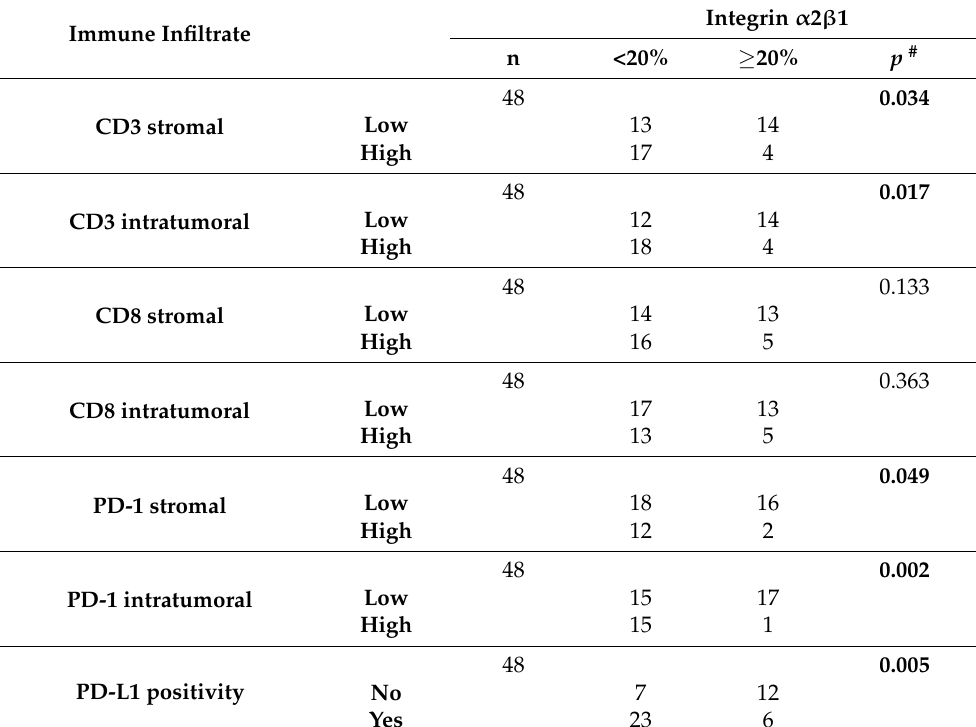
Table 6. Correlations between integrin α 2 β 1 and the immune